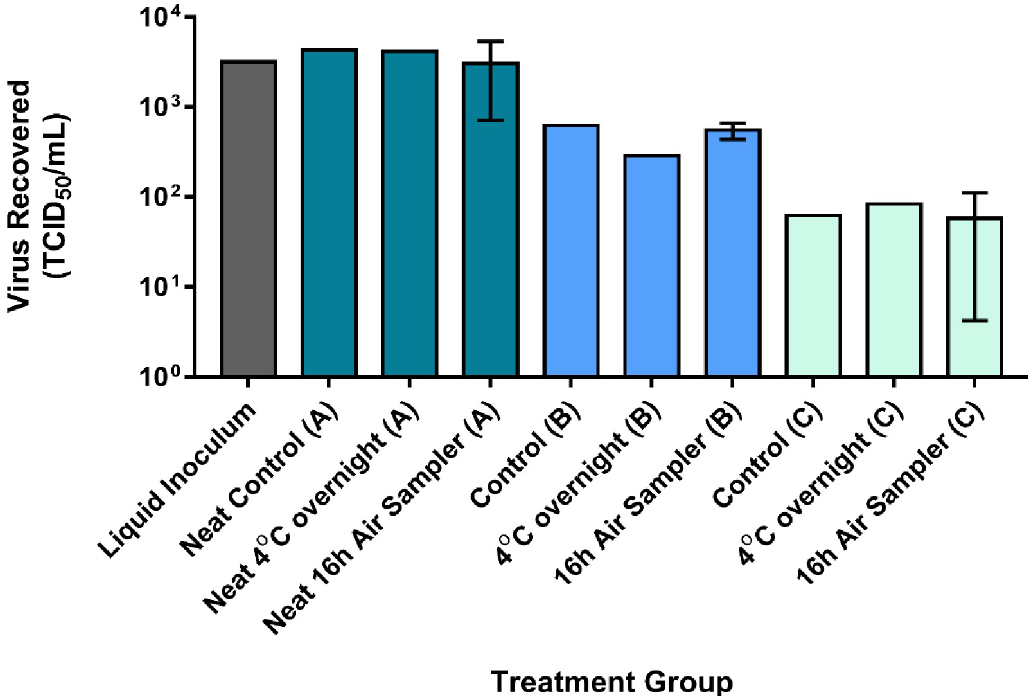
Fig 2. Impact of air sampling on SARS-CoV-2 recovery from gelatin filters. Inocula (A), (B) and (C) were intended to consist of approximately 3.5, 2.5, and 1.5 Log TCID50 of SARS-CoV-2/mL, respectively, with (A) undiluted (neat), and (B) and (C) diluted from the initial Liquid Inoculum. Following one hour of drying, inoculated filters were either placed in UPAS units for 16 hours (Air Sampler), dissolved in VTM and processed immediately (Control), or dissolved at placed at 4˚C overnight prior to processing (4˚C). Results represent viable virus recovered in VeroE6 cells by TCID 50 assay. Whiskers represent standard deviation of replicate